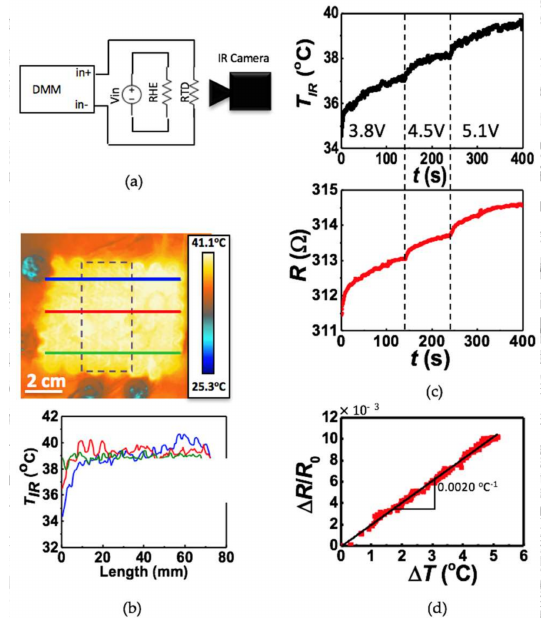
Figure 3. ( a ) Circuit diagram of set-up for calibration of RTD in situ. Heater is brought to different temperatures by adjusting Vin. Resistance and temperature are measured simultaneously using a digital multimeter (DMM) and IR camera, respectively; ( b ) Lateral heat distribution of heater. Blue, red and green lines on IR image mark the horizontal line across which temperature was measured for their respective red, blue and green plots. Temperature distribution is fairly uniform. Dotted purple line on IR image shows area that the IR camera calculated the average temperature for; ( c ) Average temperature of area marked by the dotted purple line in Figure 3b (top) and resistance of Au/Cr RTD as measured by DMM (bottom) each plotted across time as Vin was changed to 3.8 V, 4.5 V and finally 5.1 V; ( d ) The calibration curve for the RTD: ∆ R/R 0 of the RTD versus ∆ T of the average temperature of the area around the RTD as marked by the dotted purple line in Figure 3b. The calibration constant, β , is marked and is equal to